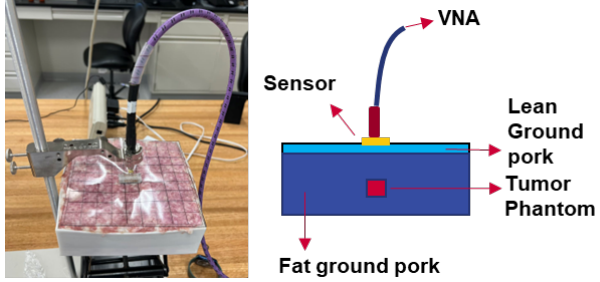
Figure 13. Setup of the subcutaneous imaging measurements.